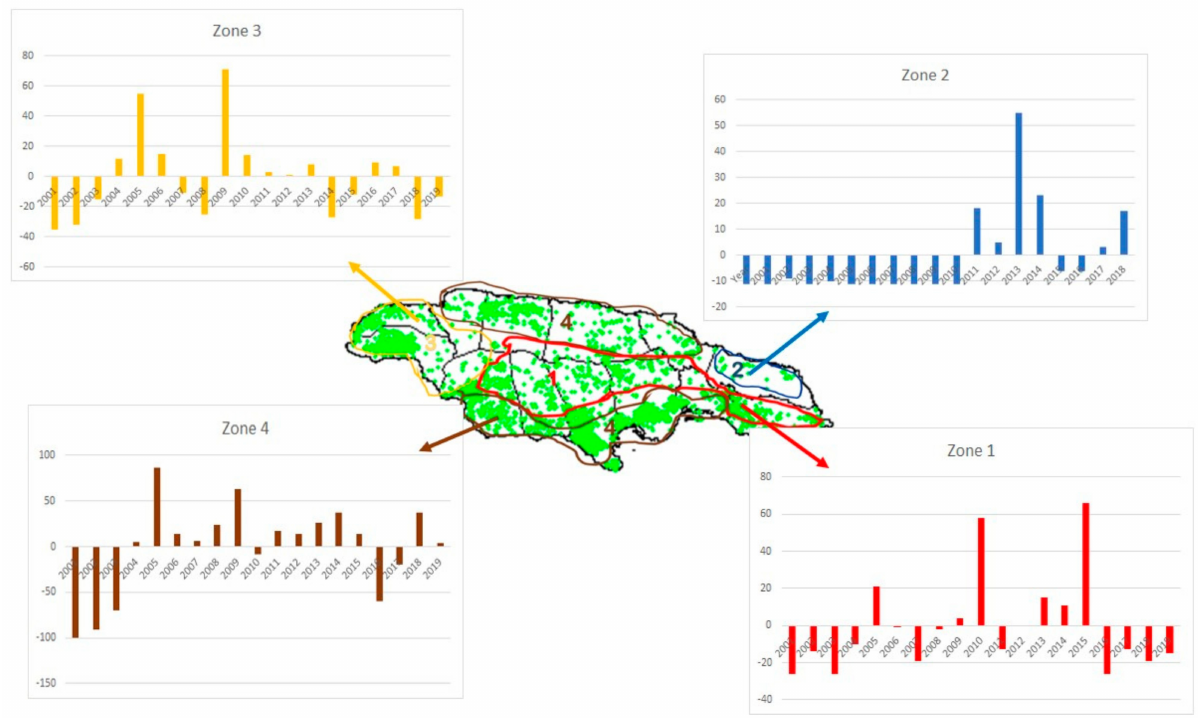
Figure 6. Map showing anomalies of annual fire occurrences for 2001–2019 by zones from the MODIS data. The approximate bounds for the four rainfall zones over Jamaica and the spatial distribution of fires are also